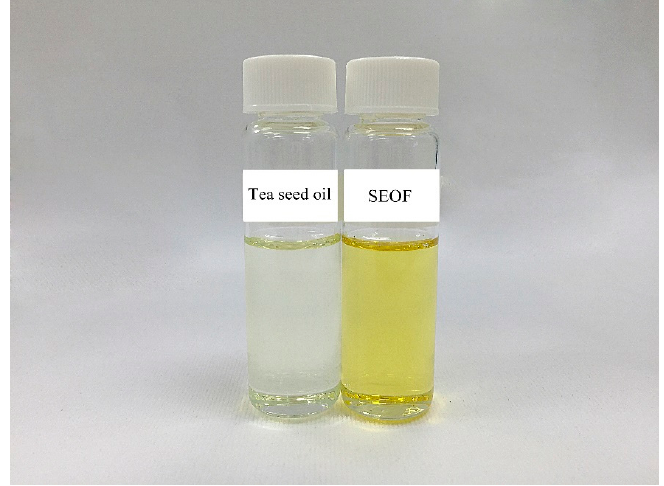
Figure 3. Appearance of tea seed oil ( left ) and SEOF (A1) ( right ).